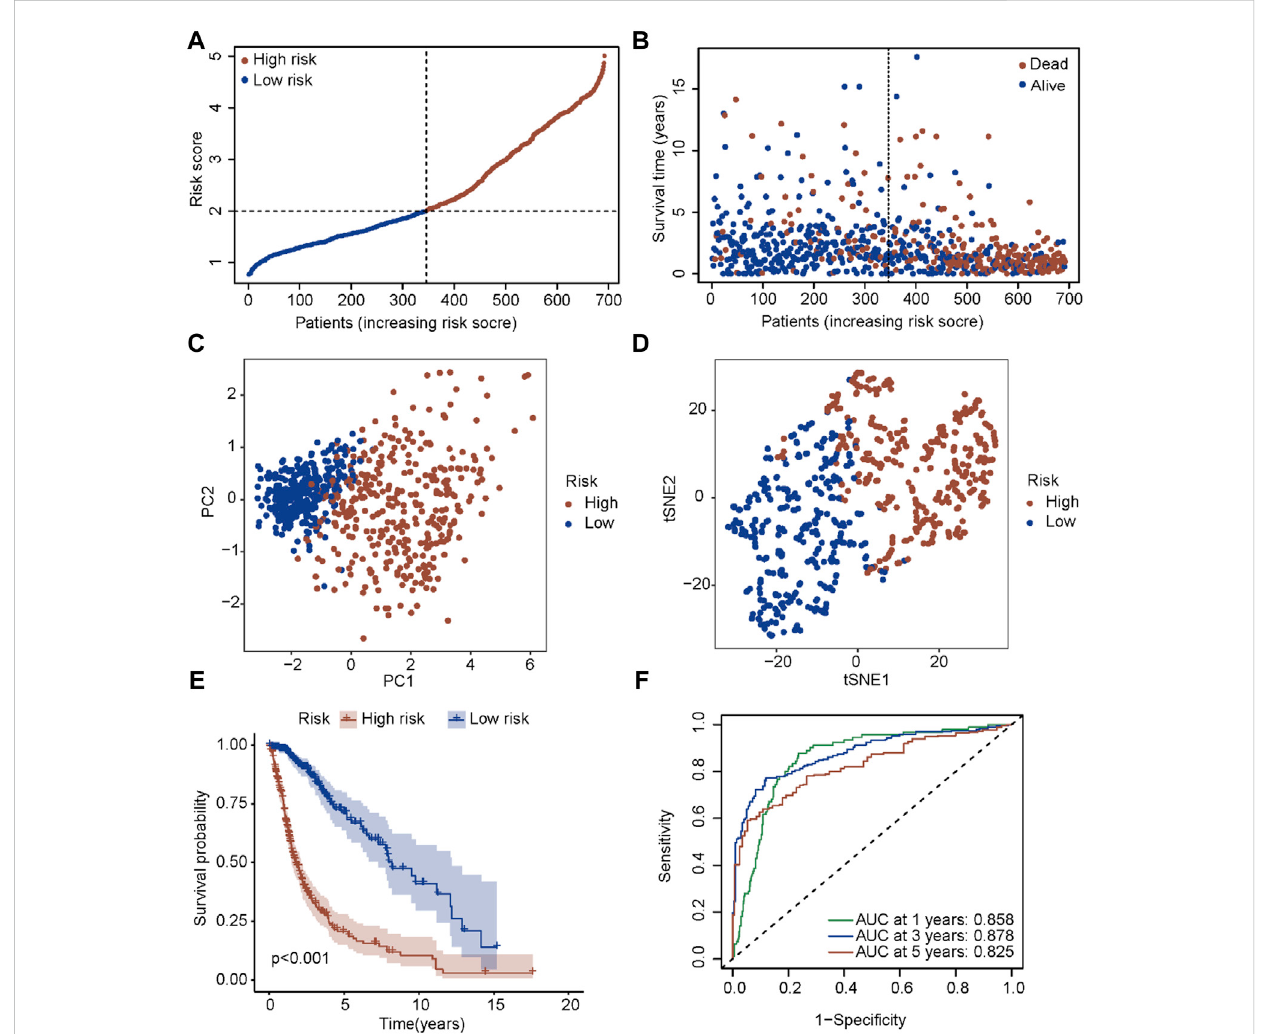
FIGURE 4 Prognostic analysis of the fi ve-gene signature in the TCGA cohort. (A) The distribution and median value of the risk scores in the TCGA cohort. (B) The distributions of OS status, OS time and risk score in the TCGA cohort. (C) PCA plot of the TCGA cohort. (D) t-SNE analysis of the TCGA cohort. (E) Kaplan-MeiercurvesfortheOSofpatientsinthehigh-riskgroupandlow-riskgroupintheTCGAcohort. (F) AUCoftime-dependentROCcurvesveri fi ed the prognostic performance of the risk score in the TCGA